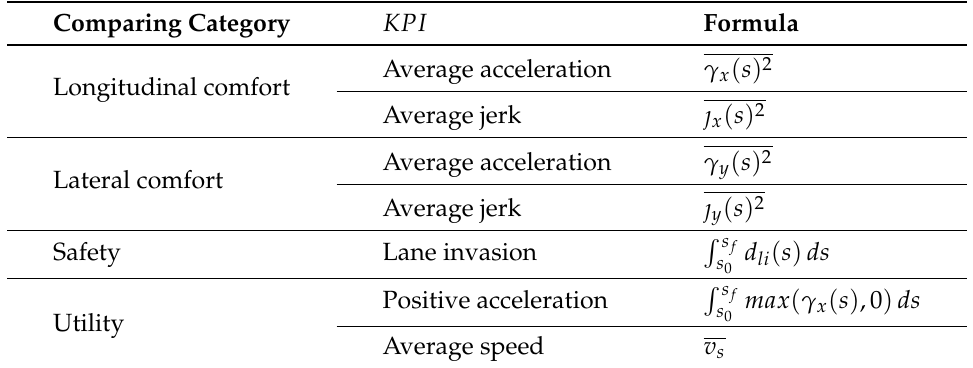
Table 5. Key performance indicators used to compare the performance of different